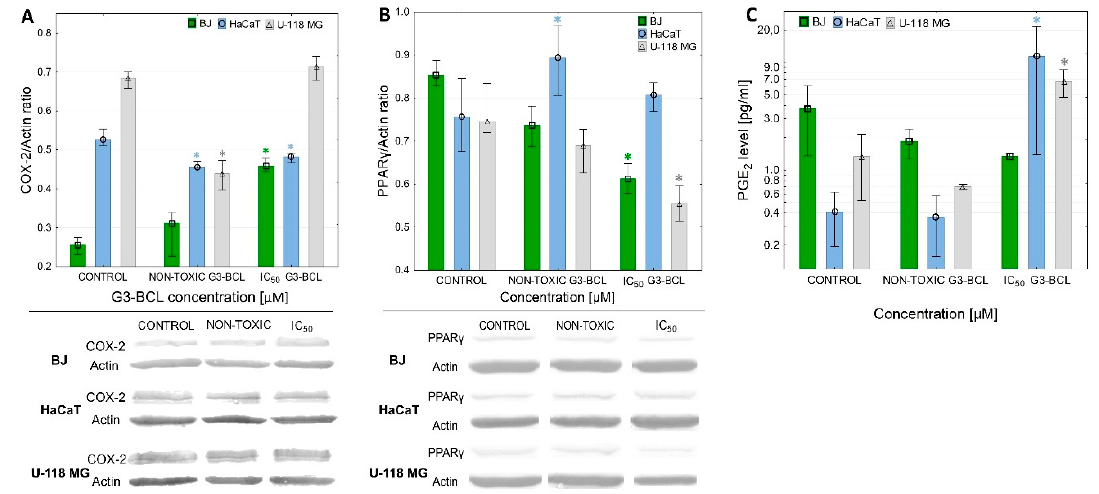
Figure 8. E ff ect of G3-BCL on expression of COX-2 protein (A), PPAR γ (B) and PGE 2 production (C) in BJ, HaCaT and U-118 MG cells after 24 h treatment with non-toxic (0.5 µ M) or IC 50 concentrations (estimated with XTT assay). Levels of COX-2 protein were calculated against β -actin and expressed as the percent of the control. Squares indicates medians and whiskers corresponding to the lower (25%) and upper (75%) quartile ranges. * P < 0.05 signi fi cant di ff erence against control (Kruskal– Wallis test).